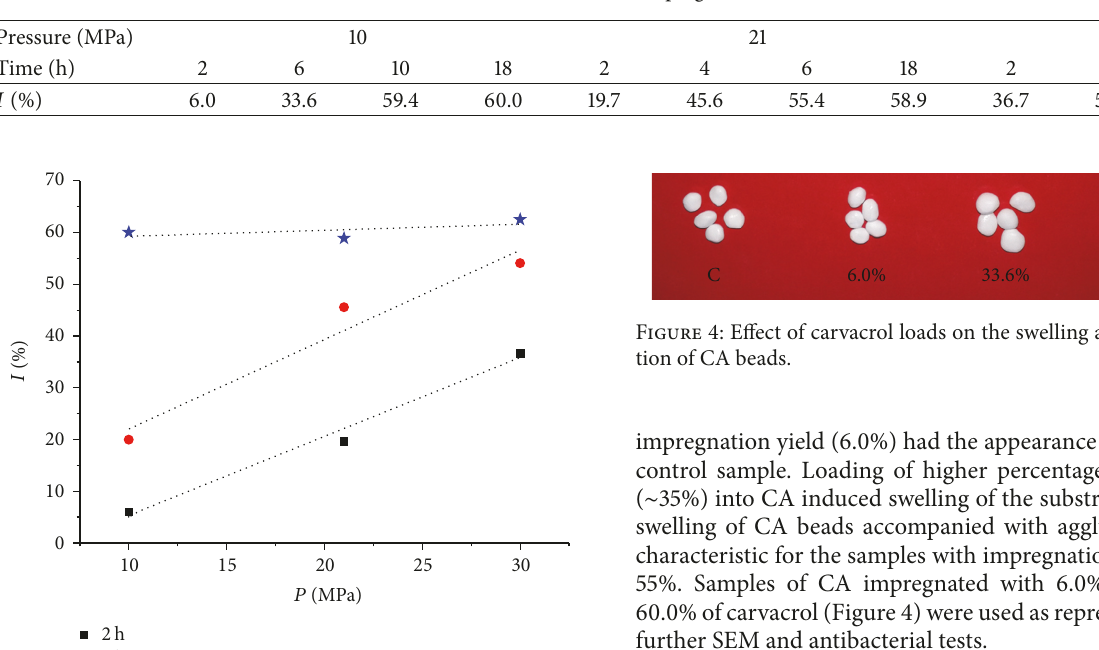
Table 1: Results of carvacrol impregnation into CA.